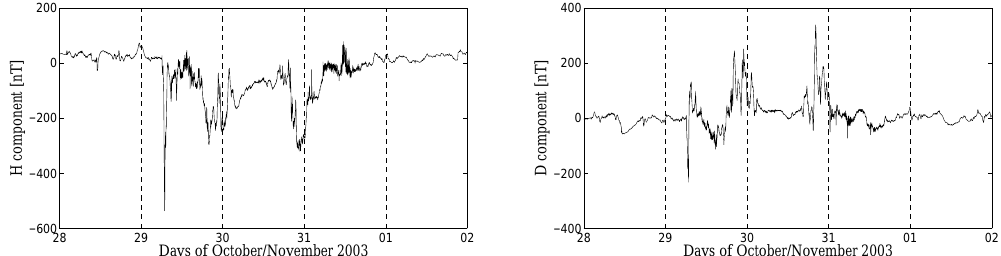
Figure 9. Halloween super storm, 28 October–1 November 2003: midlatitude ground observations (AQU: λ g = 42 . 38 ◦ N and φ g = 13 . 32 ◦ E) for the H (left panel) and D (right panel) components. The time resolution is 1min.